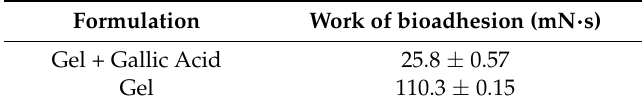
Table 5. Parameters of in vitro bioadhesion test of both gel (gel) and GA-loaded gel (gel + gallic acid). Each value represents the mean ( ± SD) of at least seven replicates. Data were collected at 32 ± 0.5 ◦